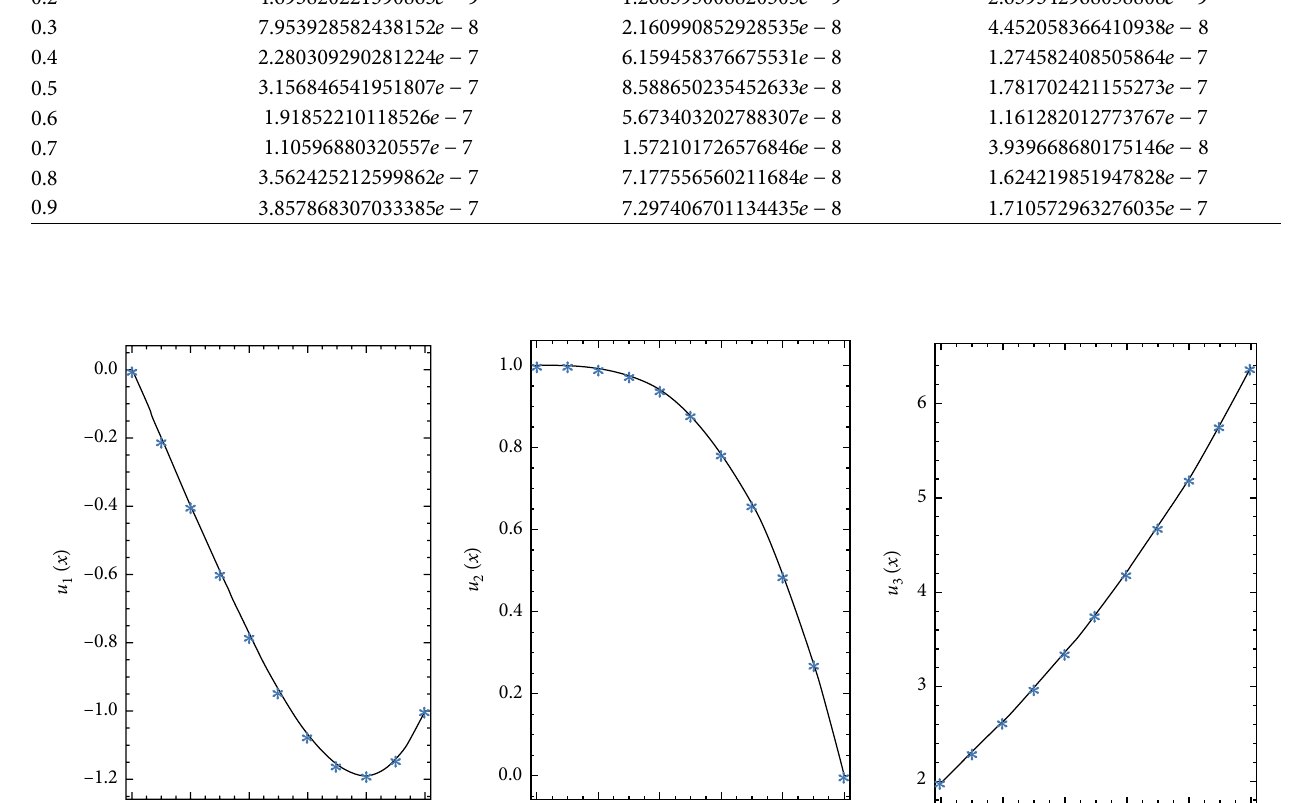
. (a) The exact and 푀 = 8 𝑢 3